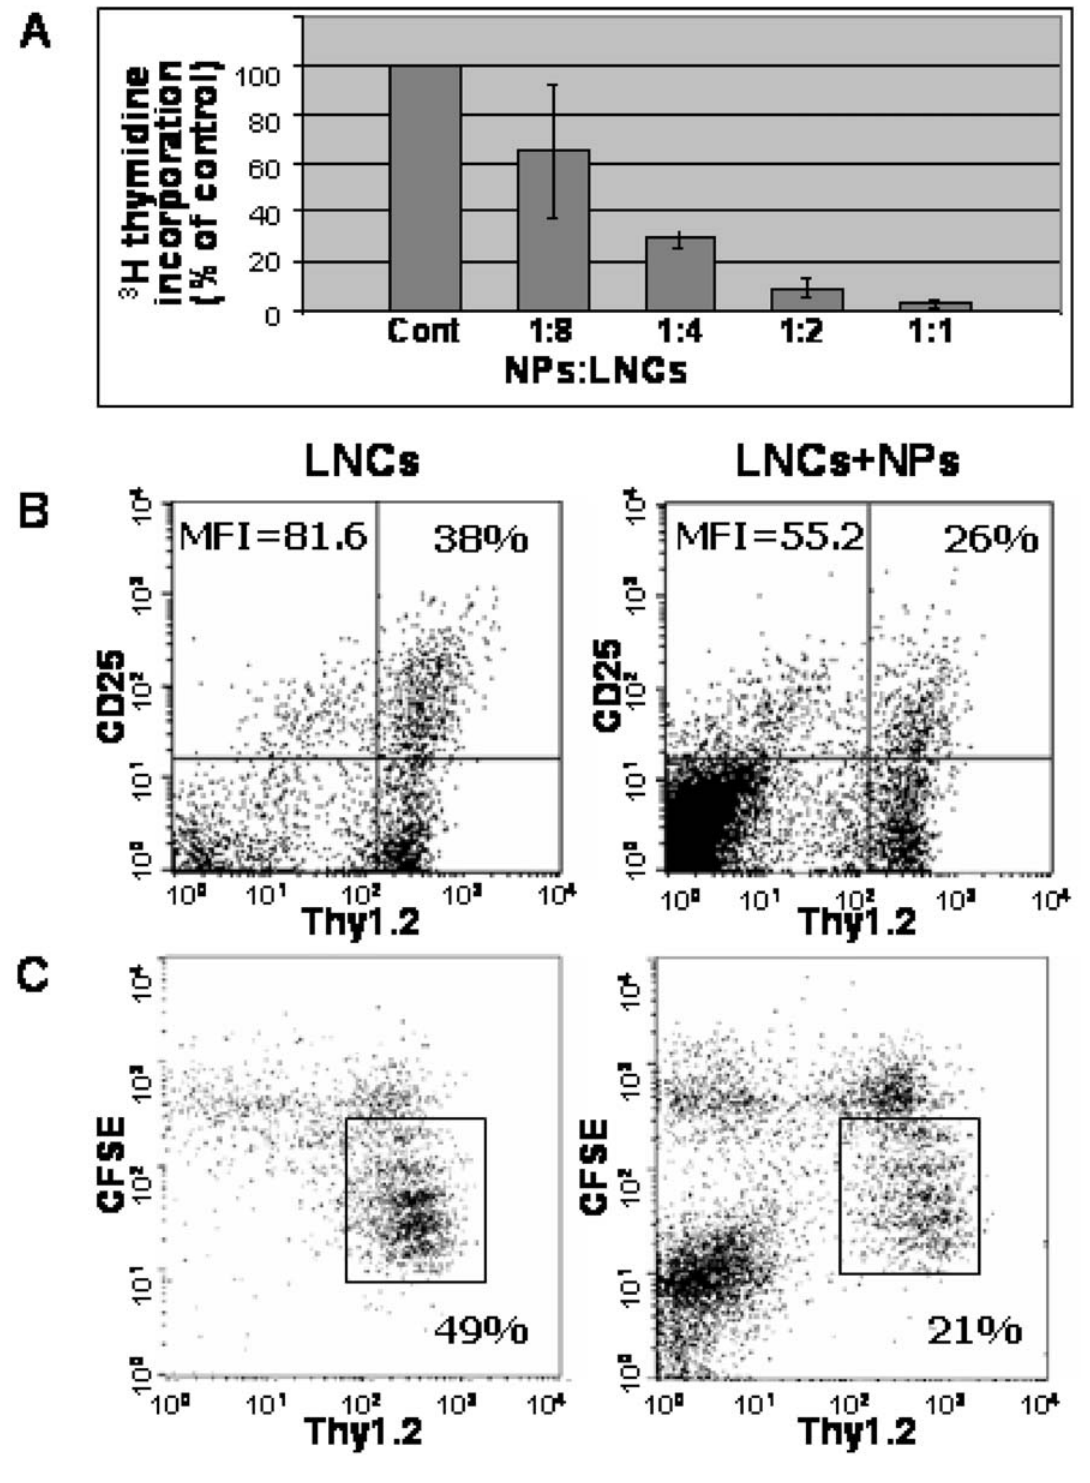
Figure 6. Direct suppressive effects of hESC-derived NPs on lymph node cells (LNCs) and T cells derived from naı ¨ ve C57BL mice. LNCs derived from naı¨ve mice were co-cultured with NPs and activated with ConA. The NPs suppressed 3 H-thymidine incorporation into the activated LNCs in a dose-dependent manner (A). FACS analysis of interleukin-2 receptor a (IL-2R a ; CD25) expression after 24 hours of ConA-stimulation showed that human NPs inhibited the activation of Thy1.2 + T cells as determined by the fraction of labeled cells and by mean fluorescent intensity (MFI) (B). FACS analysis of CFSE labeled LNCs after 72 hours of ConA stimulation showed that co-culturing with the human NPs inhibited the proliferation of Thy1.2 + T cells. The fraction of T cells that have proliferated and therefore diluted the CFSE fluorescence (within the rectangle) was reduced in the presence of the human NPs (C).